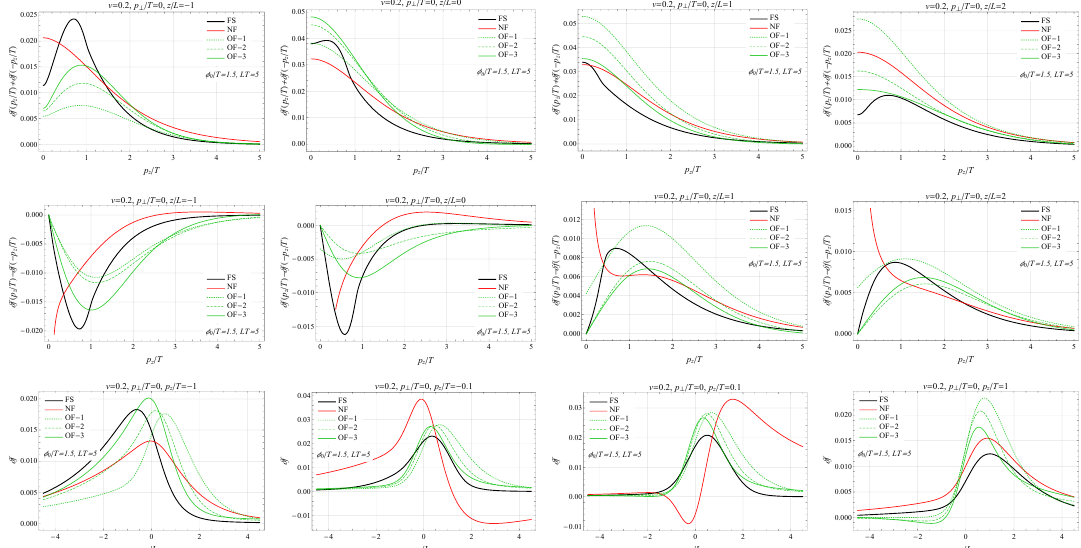
Figure 5 . Perturbation δf for v = 0 . 2 and p ⊥ = 0 . The plots on the first (second) row show the even (odd) part of δf as a function of p z for z/L = − 1 , 0 , 1 , 2 . The third row shows plots of δf as a function of z for p z /T = − 1 , − 0 . 1 , 0 . 1 , 1